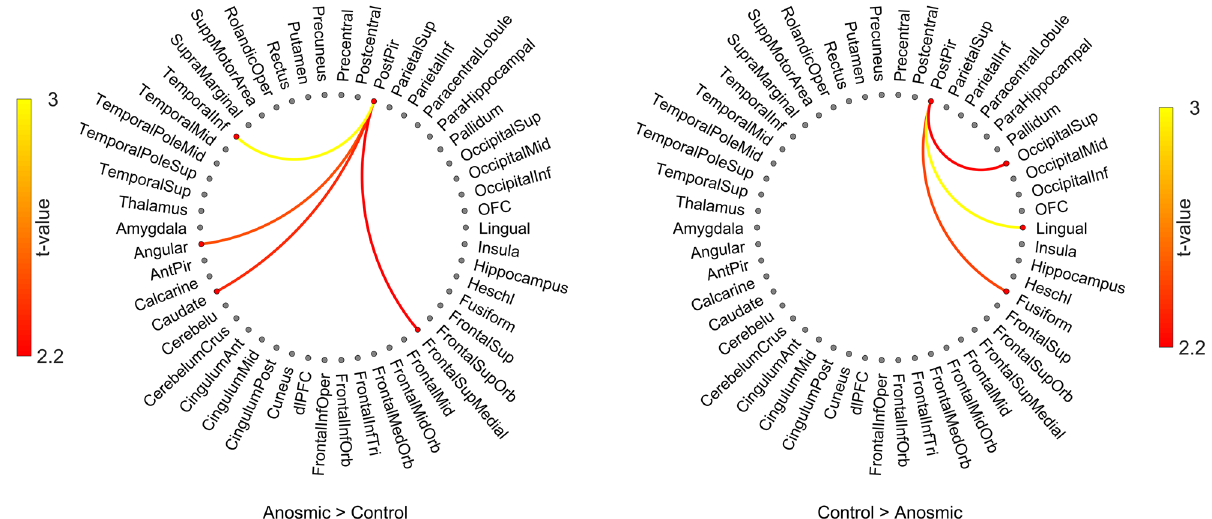
Figure 2. Dynamic functional connectivity from posterior piriform cortex. Dynamic functional connectivity from the posterior piriform cortex to other cerebral regions of interest with significant differences between groups marked with lines. Color of lines represents t -value according to color scale next to each plot. Left side plot shows where individuals with anosmia have stronger inter-regional connectivity and right-side plot shows where healthy control individuals have stronger inter-regional connectivity. Only differences with p < .05 are shown. Image created using Matlab (www. matwo rks. com) and Photoshop (www. adobe.